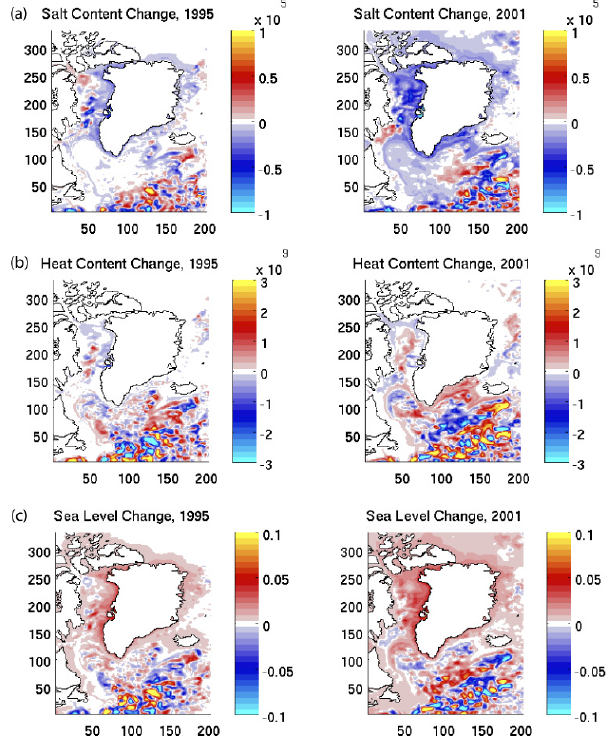
Fig. 14. Annual-mean differences (“sensitivity minus control”), in 1995 and 2001: (a) Full-depth Salt Content (kgm − 3 ) ; (b) Full- depth Heat Content (Jm − 2 ) ; (c) Sea Surface Height (m).